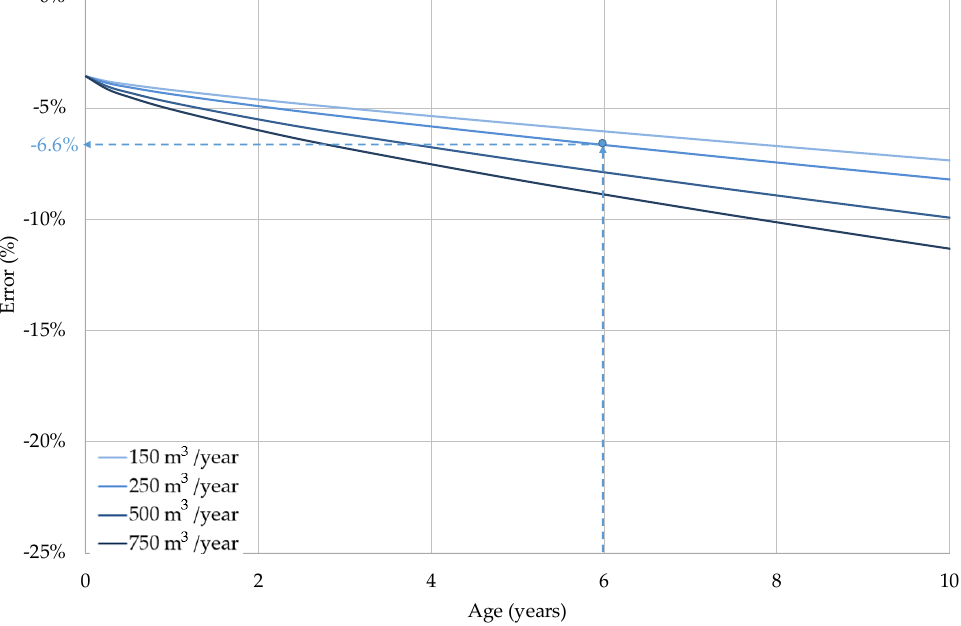
Figure 7. The degradation of the weighted error with age for different annual consumption rates (meter M_1).